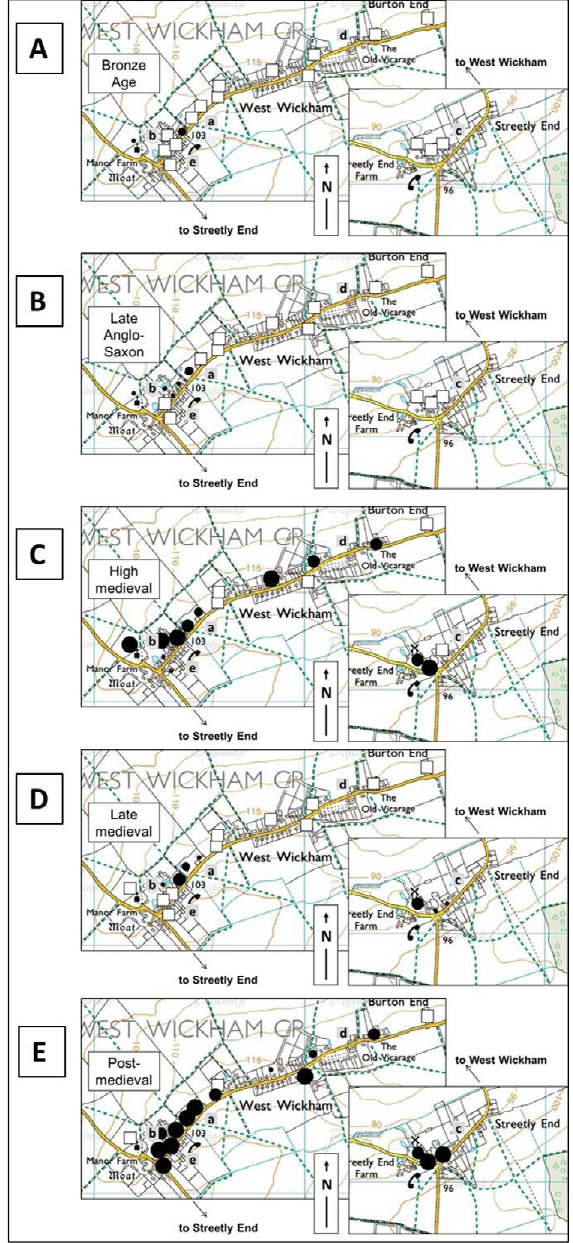
Figure 5. Pottery from test pits excavated in West Wickham. (A) Bronze Age; (B) Late Anglo-Saxon; (C) High medieval; (D) Late medieval; and (E)